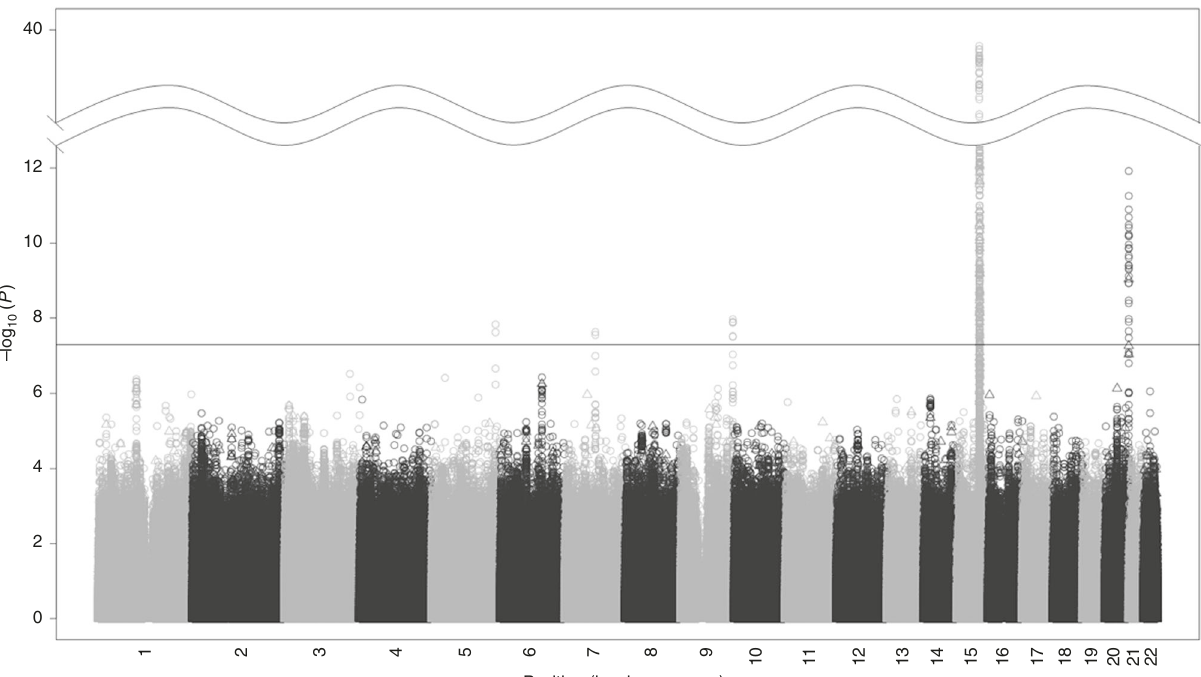
(Fig. 1). Associations of the lead SNPs (single nucleotide poly- morphisms) from each of these fi ve loci are shown in Table 1.